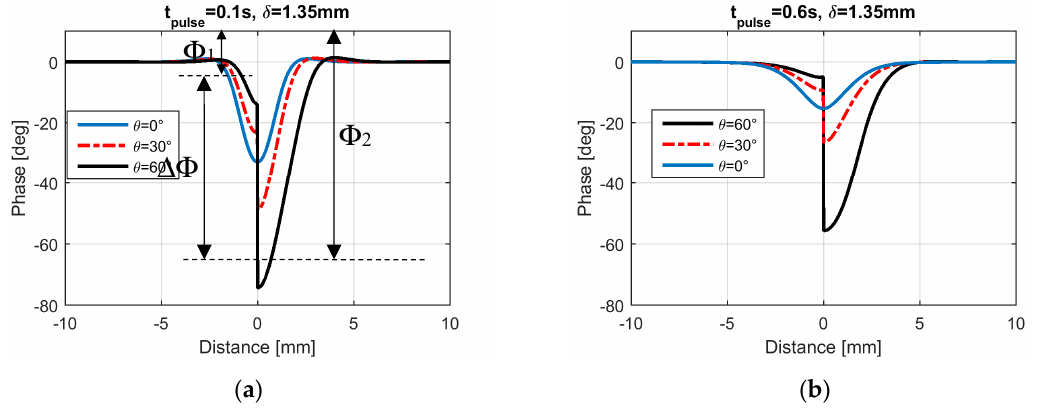
Figure 31. Phase around cracks with the same depth d = 1 mm, but with different inclination angles simulated with the simu.2 model for steel properties; ( a ) calculated for a 0.1 s pulse length and ( b ) for a 0.6 s heating duration.